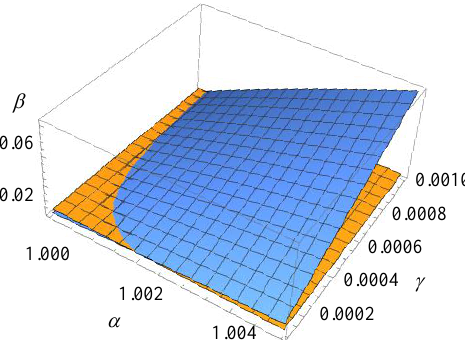
Figure 9. The 3D figures about ( α , β , γ ).